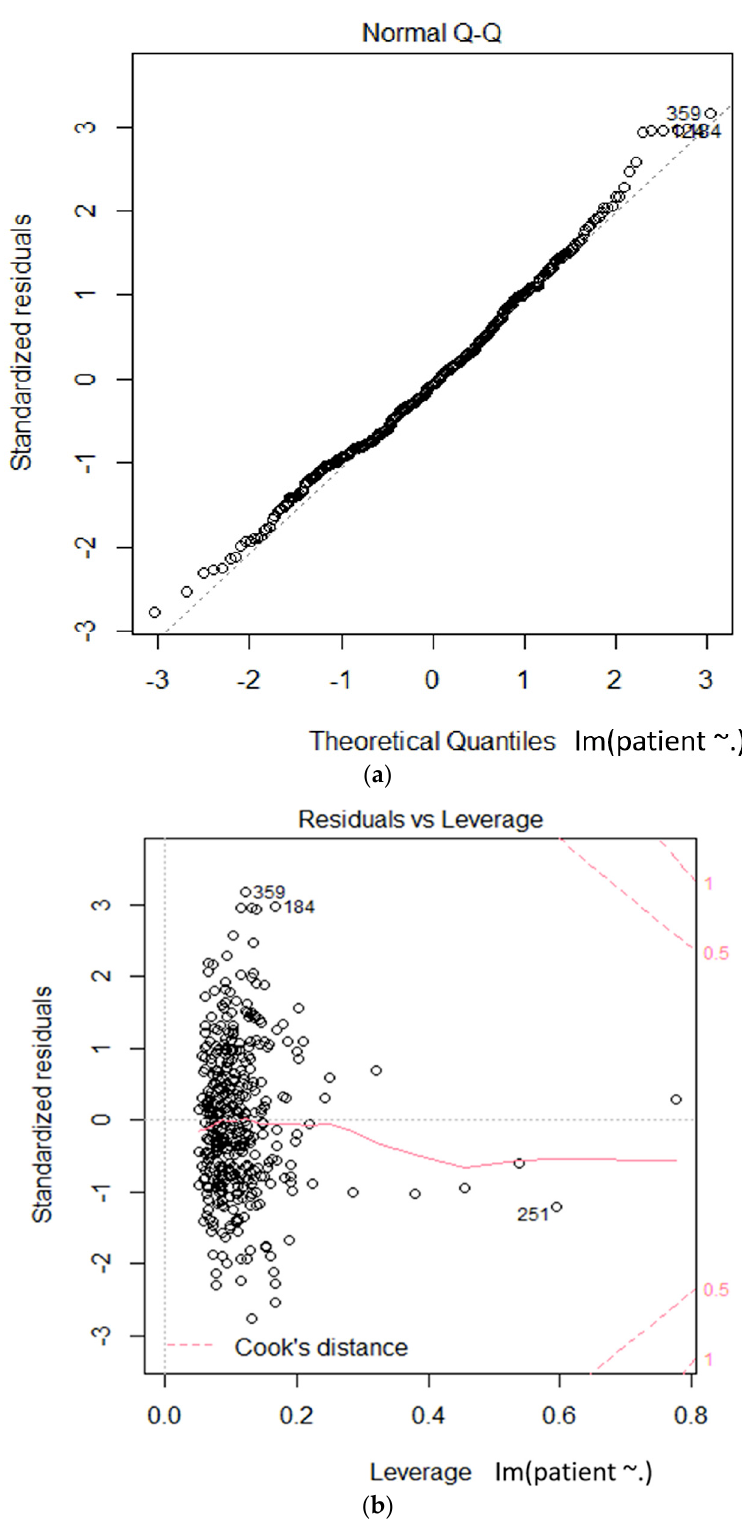
Figure 5. Linear model based statistical test on the relationships between hepatitis A and environmen- tal factors ( a ): theoretical quantiles vs standardized residuals; ( b ): leverage vs standardized